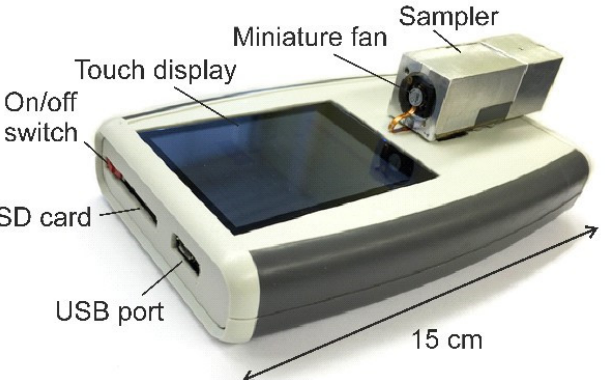
Figure 1. Pocket-size, battery-powered NP monitor “Cantor” with a weight of 0.4 kg and a power consumption of 1.25 W.